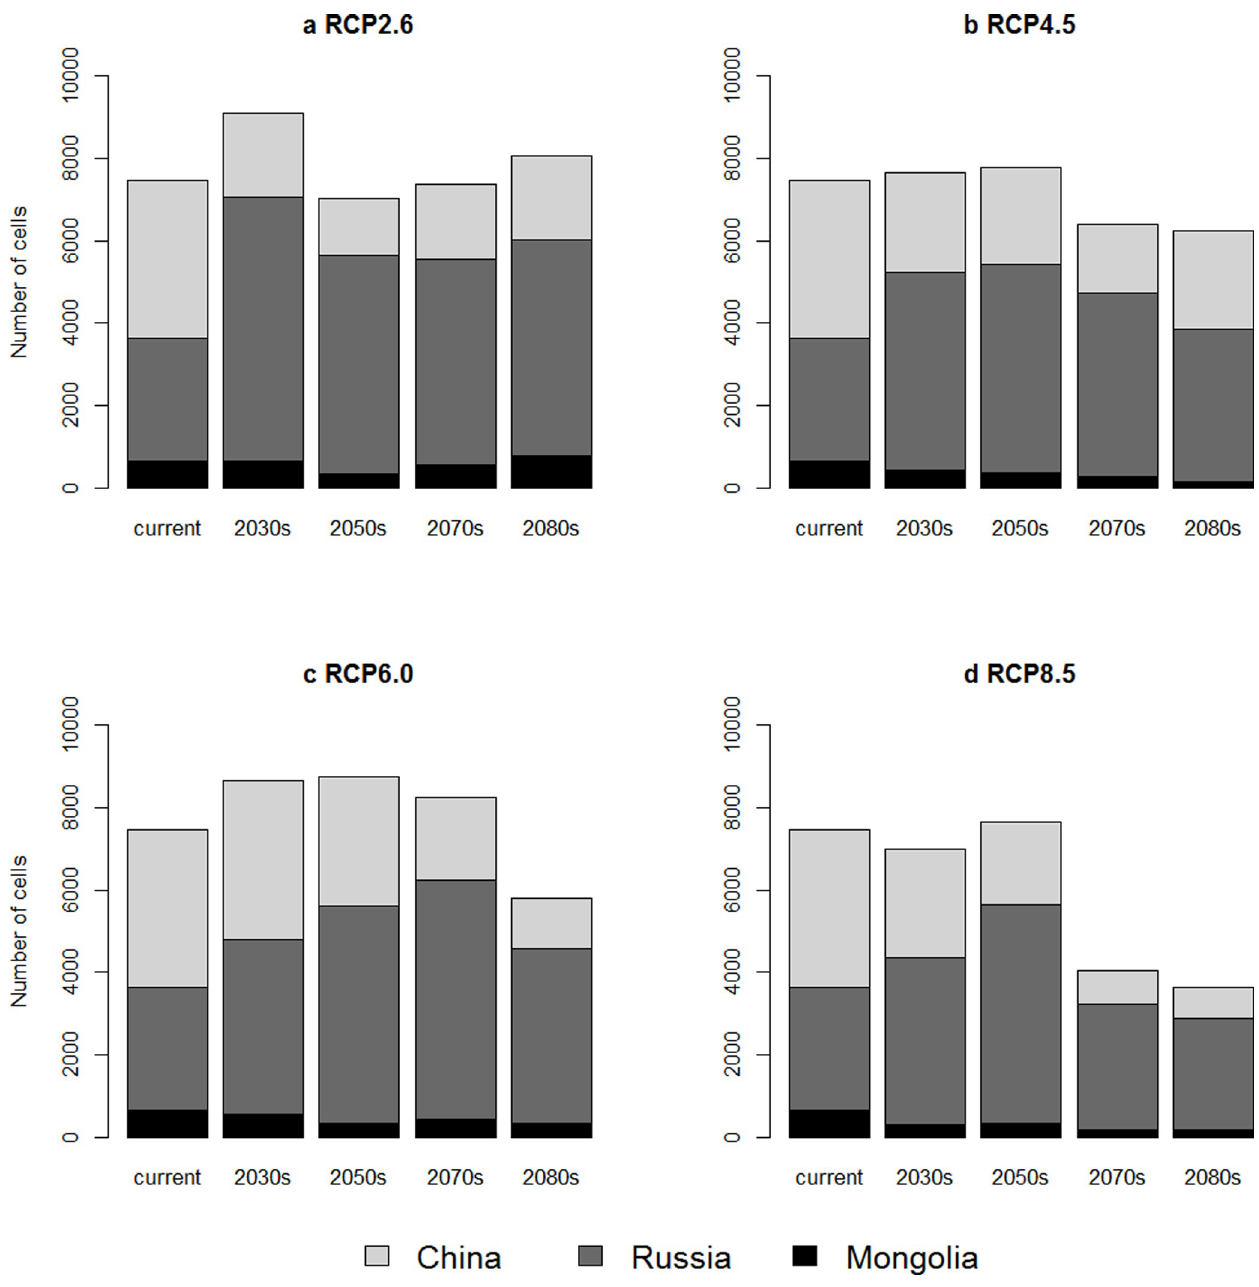
Fig 3. The number of grid cells predicted to be breeding area of the continental population of the red-crowned crane in China, Russia and Mongolia. a. low emission scenario–RCP2.6, b. intermediate scenario–RCP4.5, c. intermediate scenario–RCP6.0, d. high emission scenario–RCP8.5. https://doi.org/10.1371/journal.pone.0229984.g003 decreases under almost all emission scenarios. Our results revealed that China, which owns the largest breeding area currently, will lose most of its breeding area for the red-crowned crane. Russia, which has the second largest breeding area, will gain more breeding area in the face of climate change and would have the largest breeding area. It also means that Russia would have more responsibility to preserve this endangered species in this century.